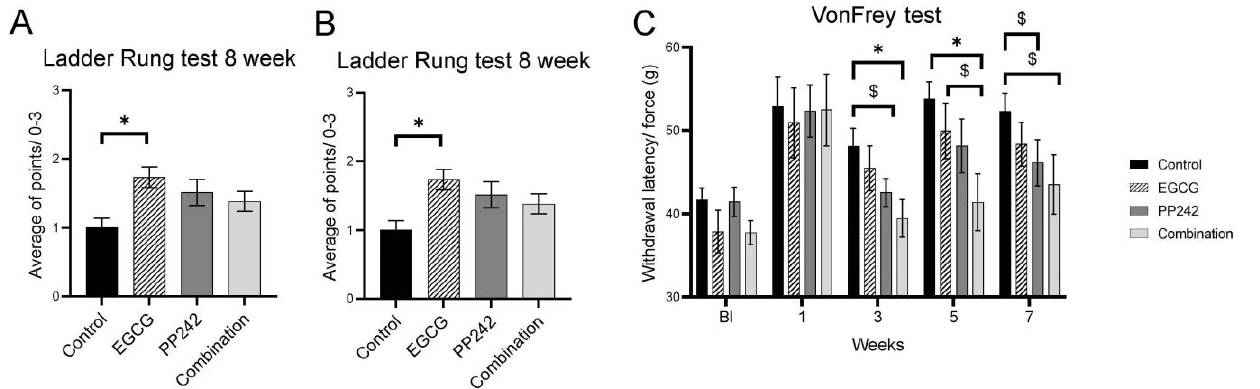
Figure 2 . Motor performance test, ladder rung test, and mechanical sensitivity test by Von Frey test. ( A , B ) The complex motor performance test using ladder rung test revealed no performance difference among all tested groups in the fourth week; at 8 weeks after SCI, EGCG treatment significantly improved motor performance in the ladder rung test. ( C ) Mechanical sensitivity using the Von Frey test displayed significantly better withdrawal latency at weeks three and five after SCI in EGCG + PP242-treated rats (* p < 0.05), ($ p 0.05 – 0.1).